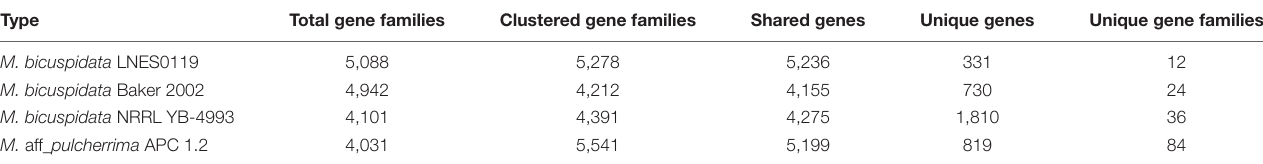
TABLE 4 | Statistics of the gene families of four Metschnikowia